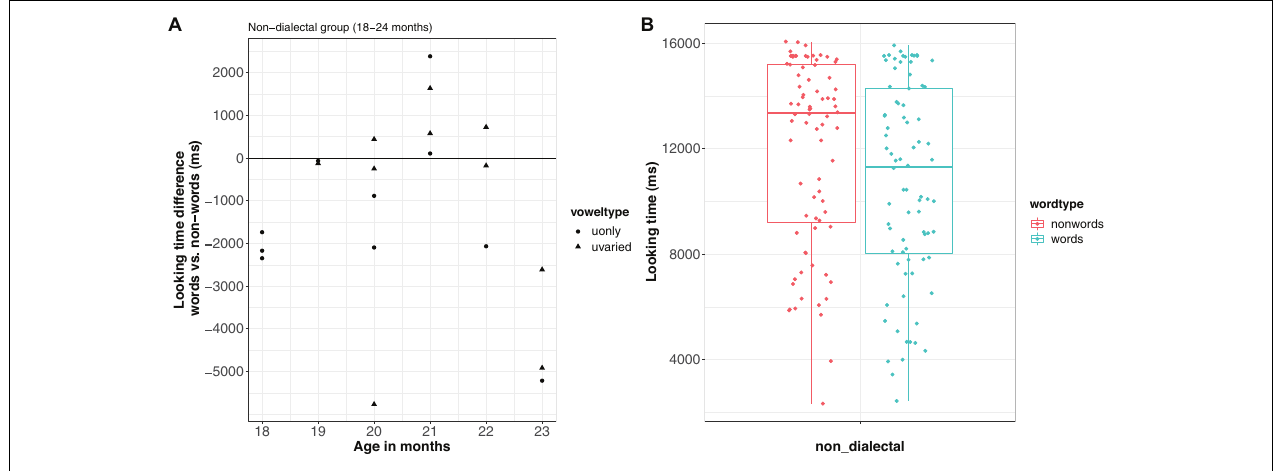
FIGURE 6 | Looking time difference between words and nonce-words in Experiment 2 (A) and looking times by word type (B) .